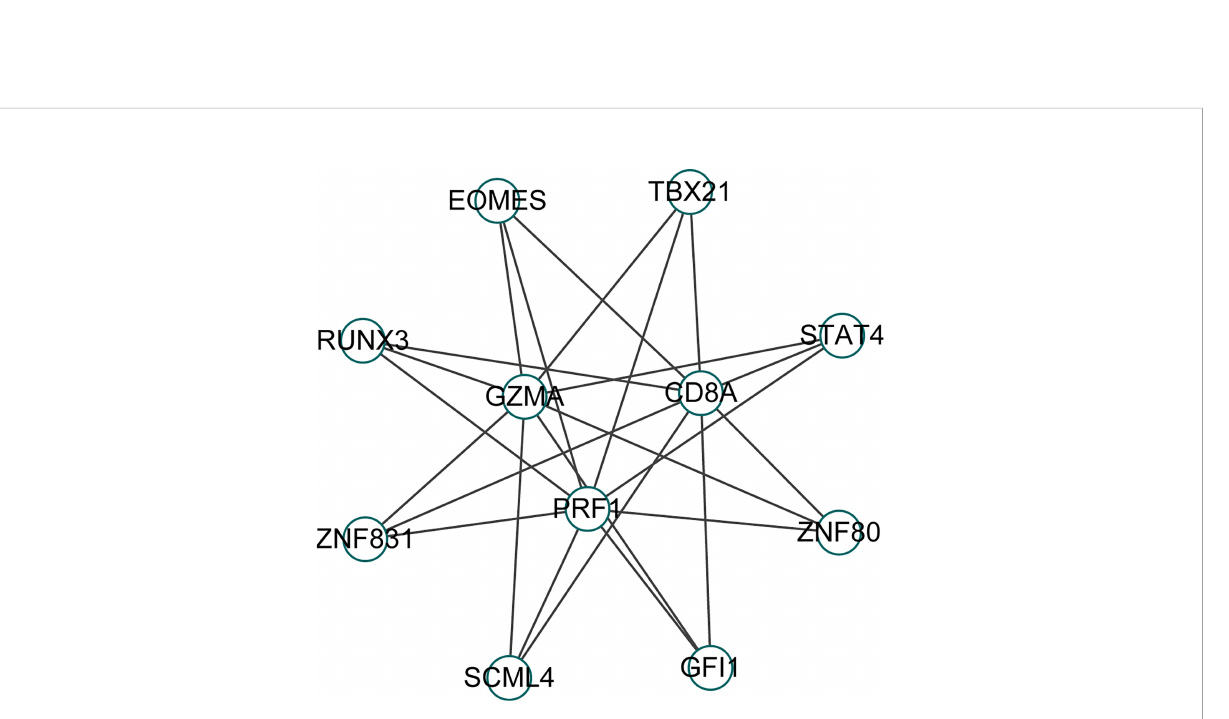
FIGURE 8 Prediction of transcription factors of Hub gene in CHEA3